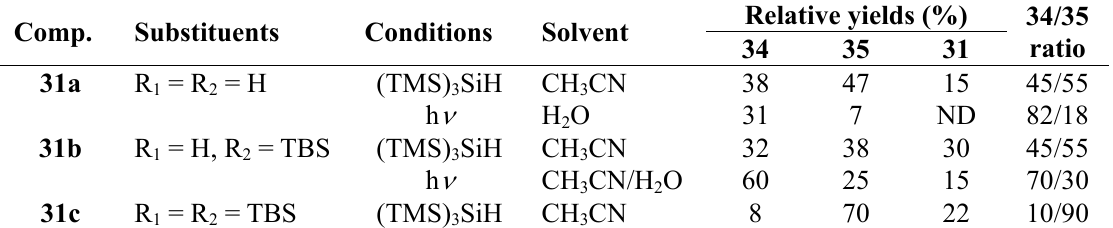
Table 2. Summary of the effects of reagents, solvents, and protecting groups in the stereochemistry of radical cascade